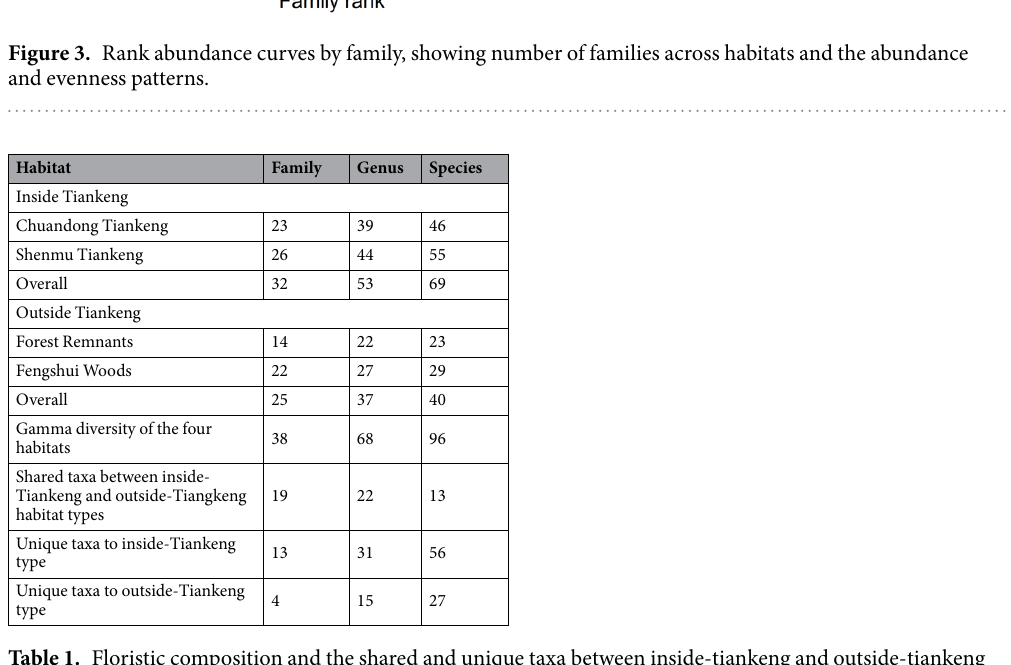
Table 1. Floristic composition and the shared and unique taxa between inside-tiankeng and outside-tiankeng